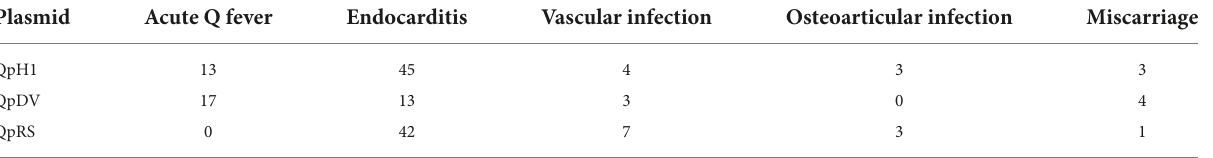
TABLE 6 Association between plasmid type and clinical presentation. Plasmid Acute Q fever Endocarditis Vascular infection Osteoarticular